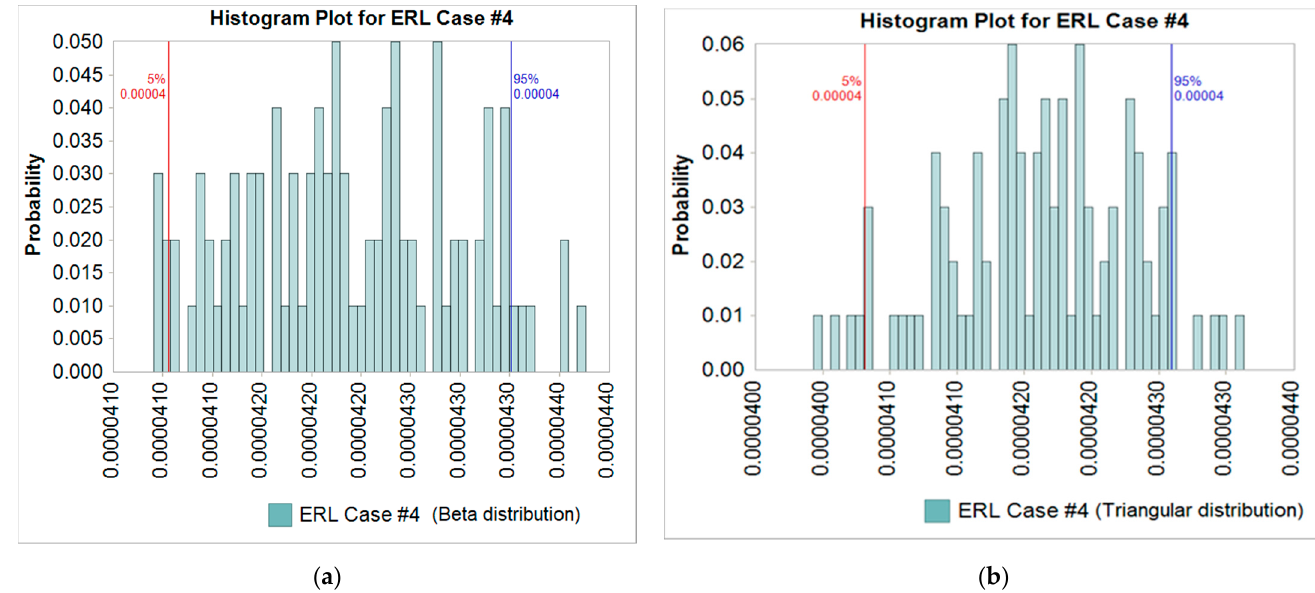
Figure 10. Case #4: Uncertainty analysis for ‘not complying with instructions’. ( a ) ERL uncertainty analysis for Case #4 with beta distribution. ( b ) ERL uncertainty analysis for Case #4 with triangular distribution.